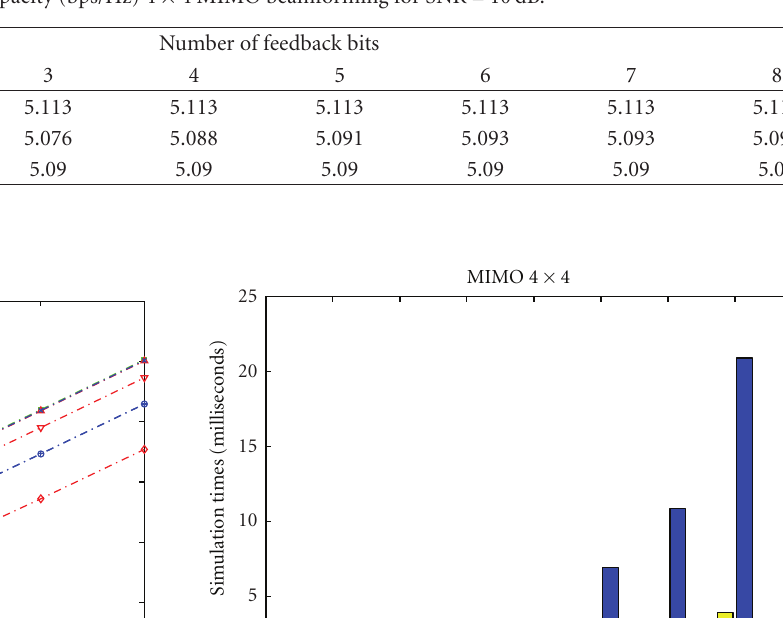
Table 1: Average capacity (bps/Hz) 4 × 4 MIMO beamforming for SNR = 10dB.